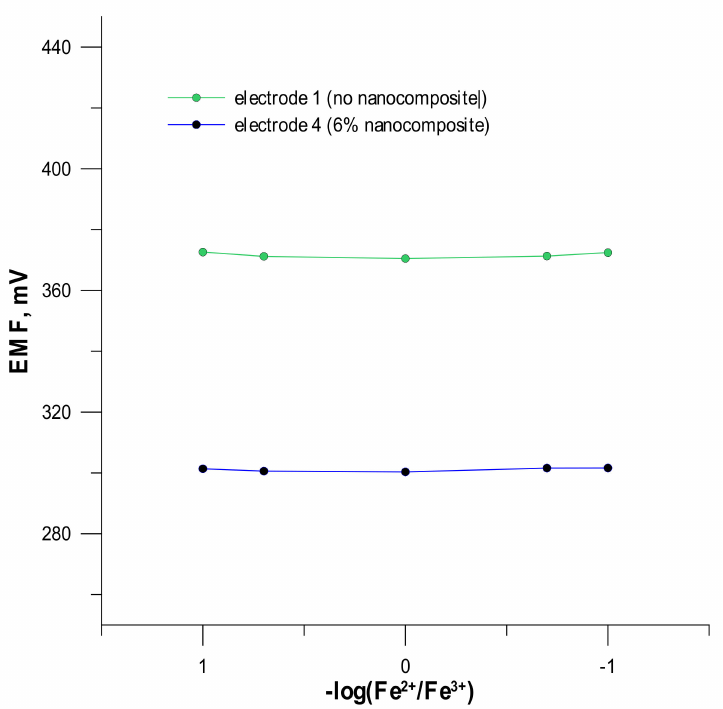
Figure 6. Redox sensitivity test for electrode 1 and modified electrode 4.